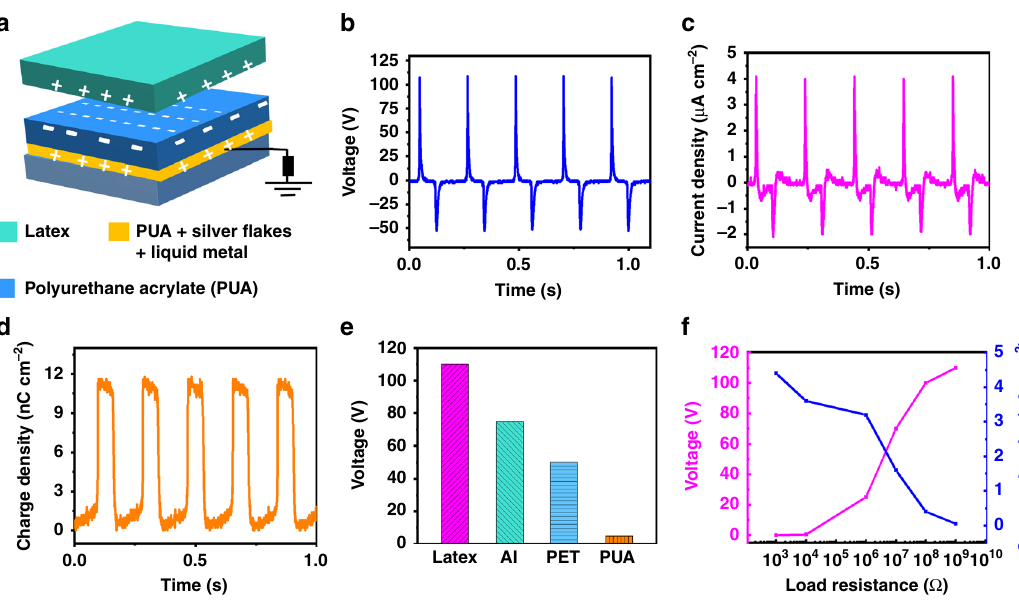
Fig. 3 Schematic diagram and energy-harvesting performance. a Schematic diagram of the complete stack of stretchable and healable triboelectric nanogenerator (SH-TENG), where latex is used a the positive triboelectric layer, polyurethane acrylate (PUA) is used as the negative triboelectric layer and (polyurethane acrylate + silver fl akes + liquid metal) is used as the current collector. The performance of the SH-TENG was evaluated when it was subjected to a mechanical force of 40 N at a frequency of 5 Hz. b Output voltage ( V op ), c current density ( I s ), d charge-transfer density ( σ T ), and e output voltage of the SH-TENG with PUA as the negative triboelectric material and different positive materials (latex, aluminum (Al), polyethylene terephthalate (PET), and PUA). f Variations in output voltage, current, and power density as functions of external